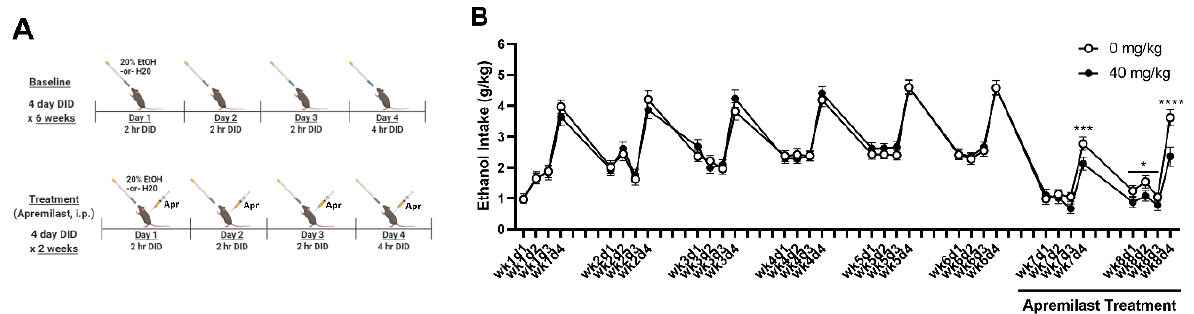
Figure 4. Treatment with the PDE4 inhibitor, apremilast, did reduce chronic binge-like ethanol intake in female and male iHDID-1 mice. ( A ) Experimental timeline for baseline binge-like ethanol drinking (weeks 1–6) and apremilast treatment relative to DID (weeks 7 & 8). ( B ) Ethanol intake (g/kg) for Days 1–4 across 6 weeks with apremilast treatment administered in weeks 7 and 8. Main effect of treatment [F(3, 88) = 27.20; p < 0.0001] and ZT [F(1, 82) = 4.33; p < 0.05] during Days 1–3 during weeks 7 and 8. Average 4 h intake on Day 4 revealed a main effect of treatment [F(1, 82) = 53.61; p < 0.0001] and a treatment x time interaction [F(1, 82) = 7.08; p < 0.0001]. No main effects of sex; thus, data are collapsed across sex. * = p < 0.05; *** = p < 0.001; **** < 0.0001